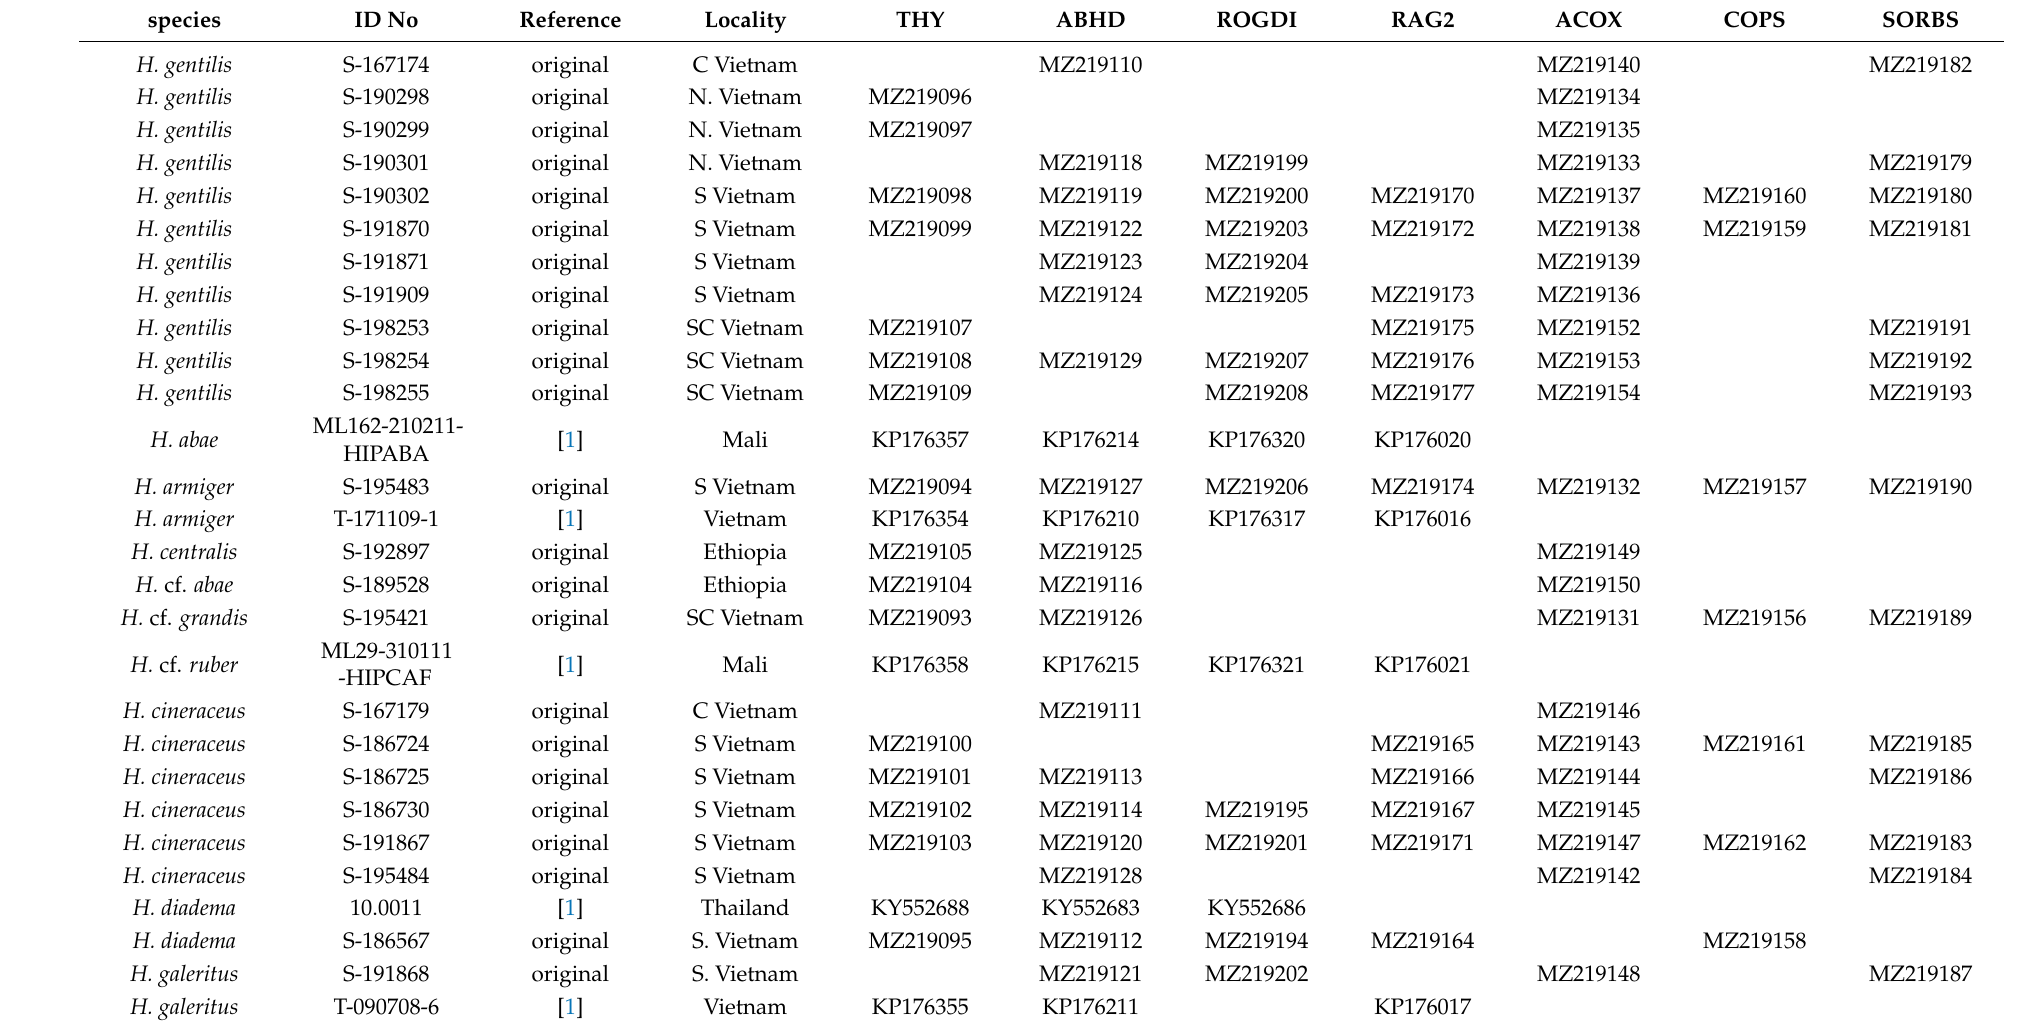
Table 2. List of specimens used in the nuclear genes